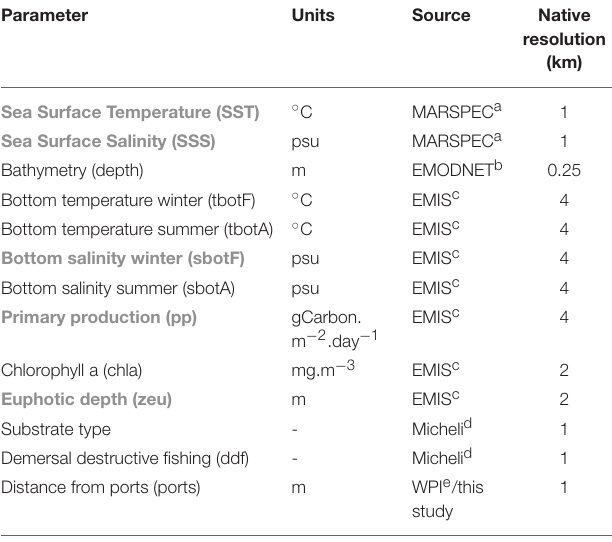
TABLE 1 | Environmental variables considered for modeling polychaete assembalges (abbreviations in brackets used throughout the document, variables highlighted with gray were removed from the analysis due to collinearity